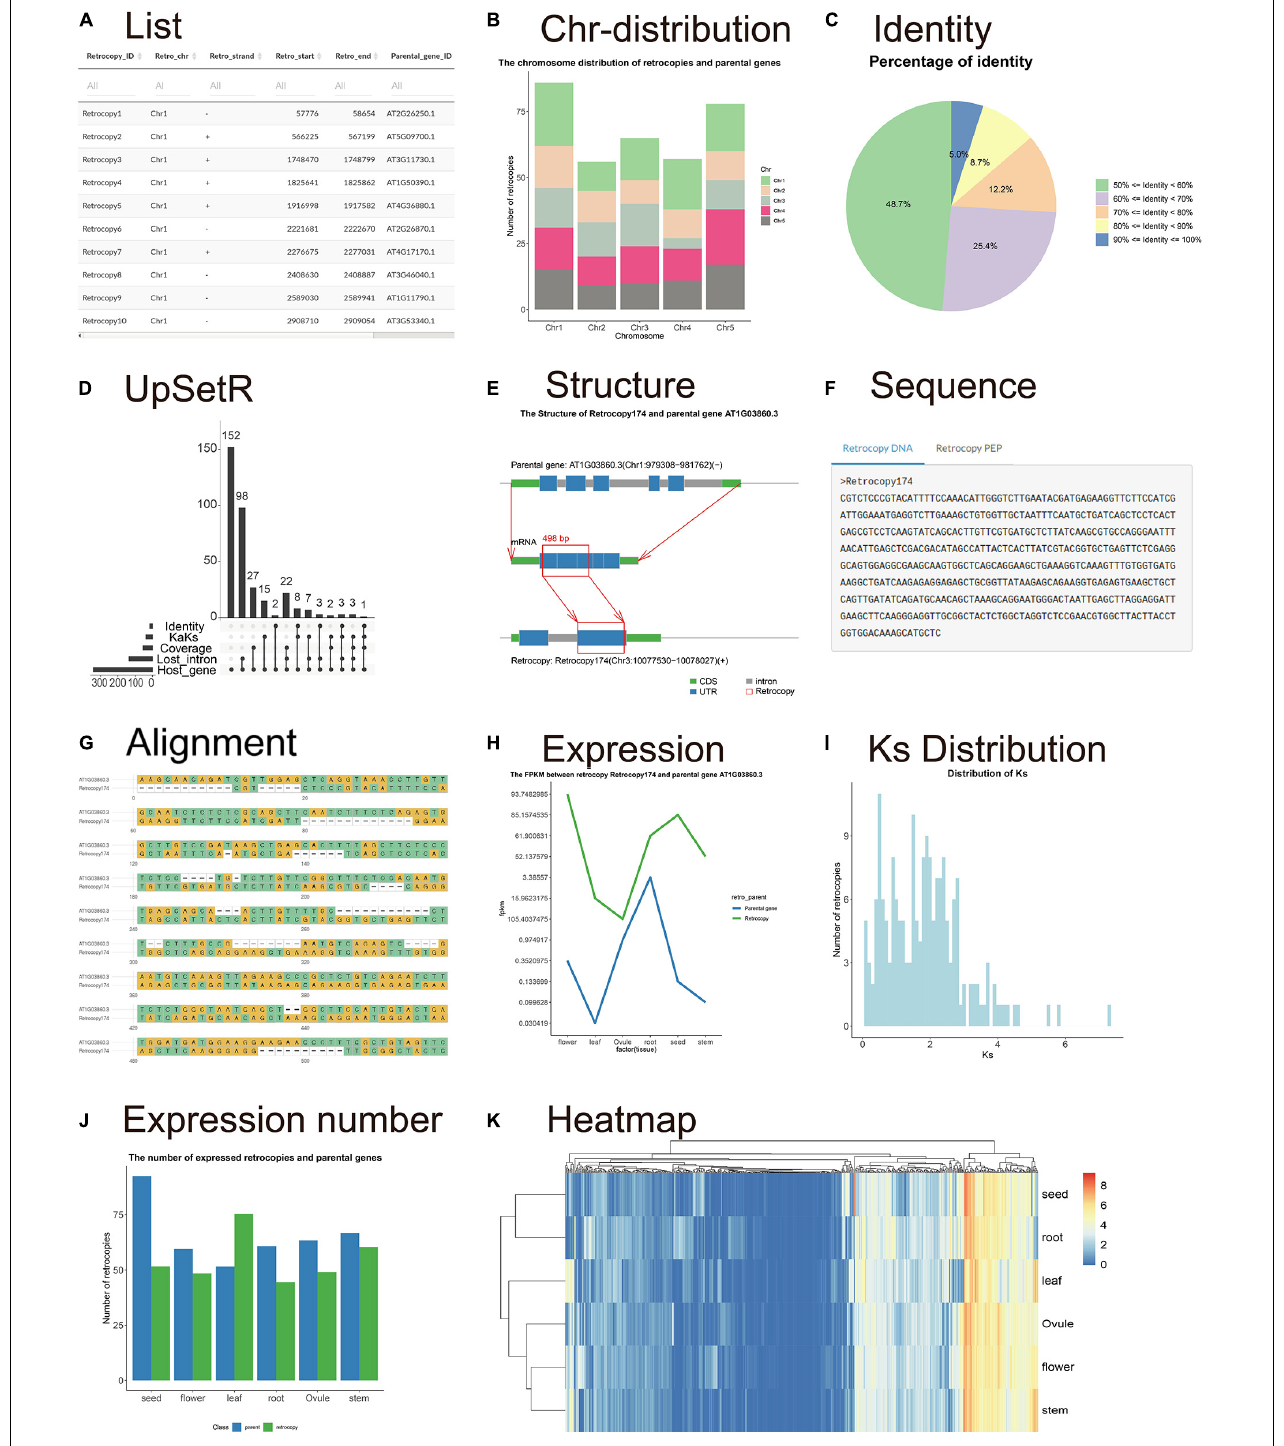
FIGURE 2 | Visualization of the retrocopy results. (A) The table contains all information on retrocopies and parental genes. (B) The chromosome distribution of retrocopies. (C) The percentage of identity. (D) The UpSet plot visualizes the intersections of datasets showing an identity ≥ 90%, ≥ 3 lost introns, host genes, Ka/Ks ≤ 0.1 and coverage ≥ 90%. (E) The structure figure shows the differences in the gene sequences between the parental genes and retrocopies. (F) The retrocopy sequence and the parental gene mRNA and protein sequences. (G) Sequence alignment between the retrocopy and parental gene. (H) The expression values of retrocopy and parental genes. (I) Ks distribution histograms. (J) Histogram showing the mean FPKM values of retrocopies (blue bar) and parental genes (brown bar) in all tissues. (K) Heatmap showing the expression of all retrocopies.